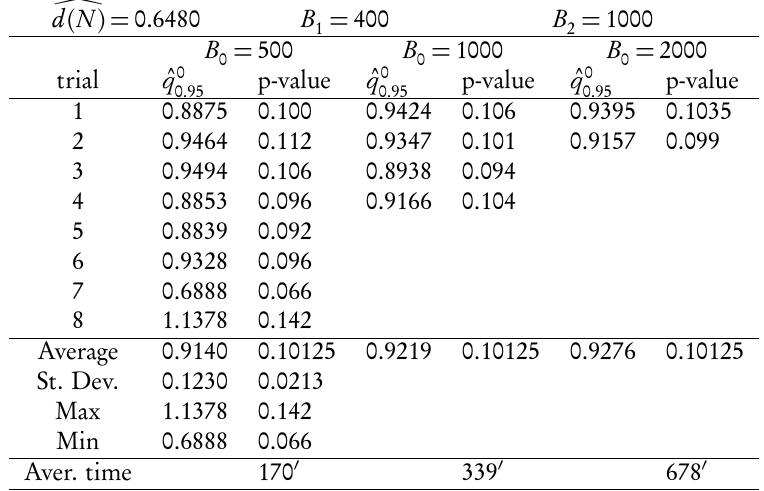
Tail properties of the predictive null distribution of d ( N ) .